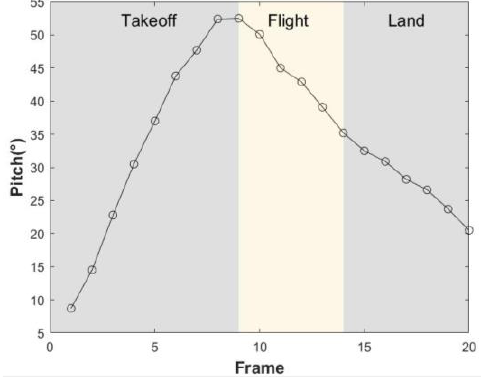
Figure 5. Changes in the pitch angle of the dog ’s body.